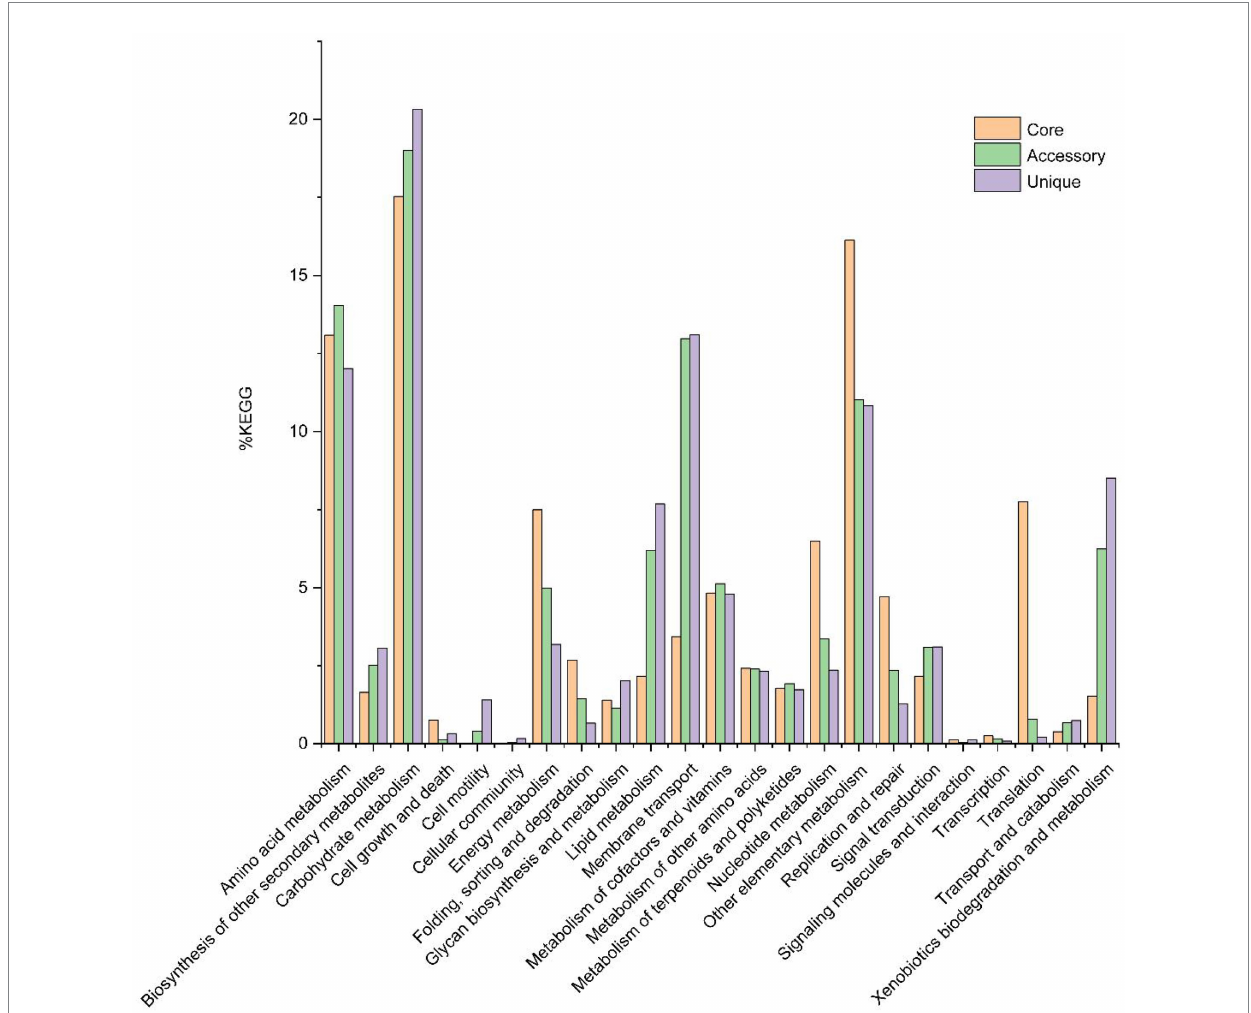
FIGURE 5 The assigned metabolic pathways associated with the core, accessory and unique genes among the genus Herbiconiux from the KEGG database (14